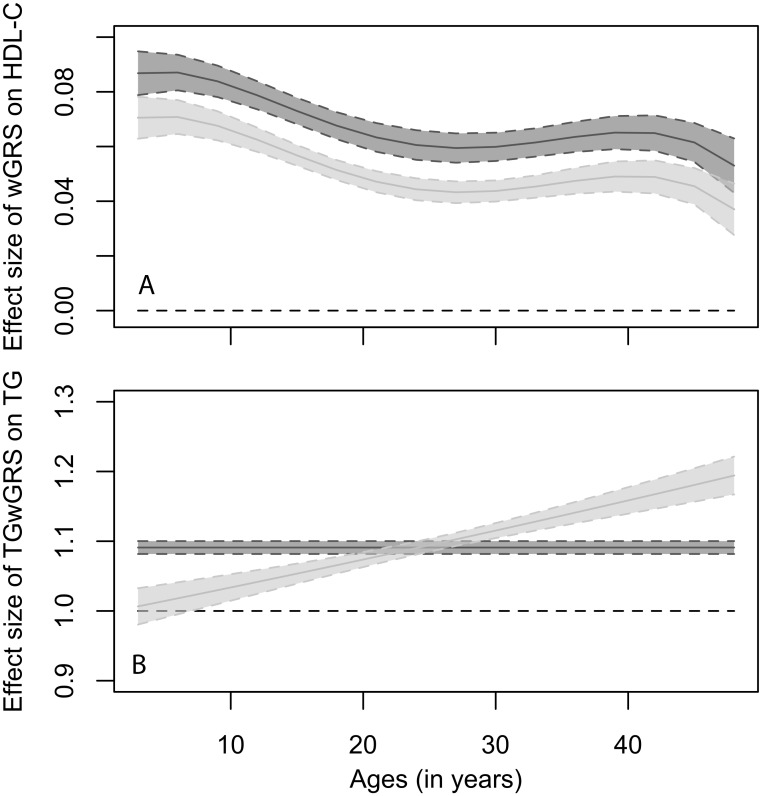
Sex-specific marginal effect* and 95% CI of (A) combined continuous HDL-C wGRS on HDL-C levels (effect size expressed in mmol/L lipoprotein level change per 1-sd change in wGRSs); and (B) combined continuous TG wGRS on fasting triglyceride levels (effect size expressed in odds ratio lipoprotein level change per 1-sd change in wGRSs).Colour code: dark grey; females, light grey; males. (*Plotted marginal effect includes the significant linear slope, quadratic and quartic rates of change (cubic trajectory parameter not significant in the final model); Horizontal black dashed line shows where the slopes are not significantly different from zero).